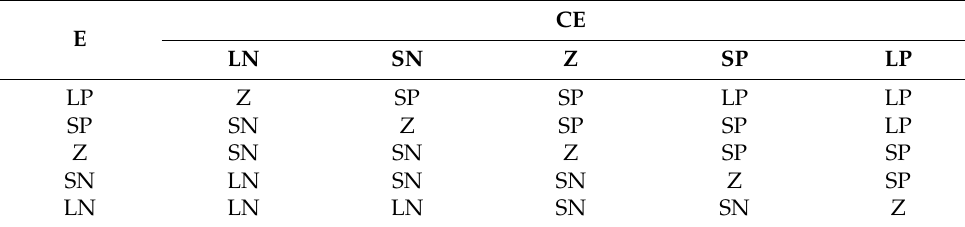
Figure 5. The MPA optimizer’s ULC-fuzzy PID controller block diagram. Figure 6. Ideal triangular input error membership functions. Figure 7. Optimal error-change input triangular membership functions.